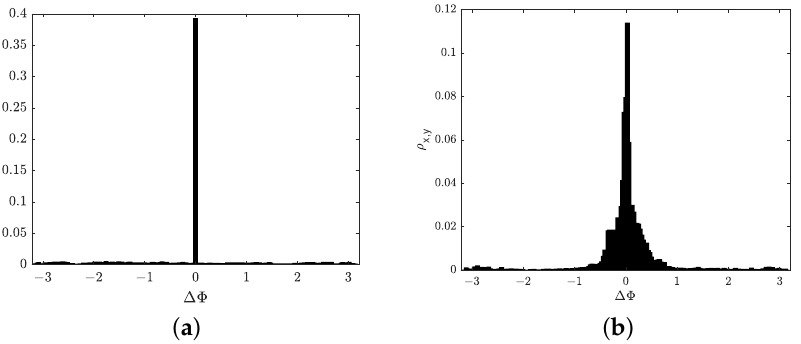
Figure 12. Histograms of portions ρ x , y for the phase difference at ridge points for two EEG channels. This example shows a phase-connected pair of Fp1-Fp2 EEG channels. ( a ) The histogram is obtained from the phase calculation by (26). ( b ) The histogram is obtained from the phase calculation by (17).